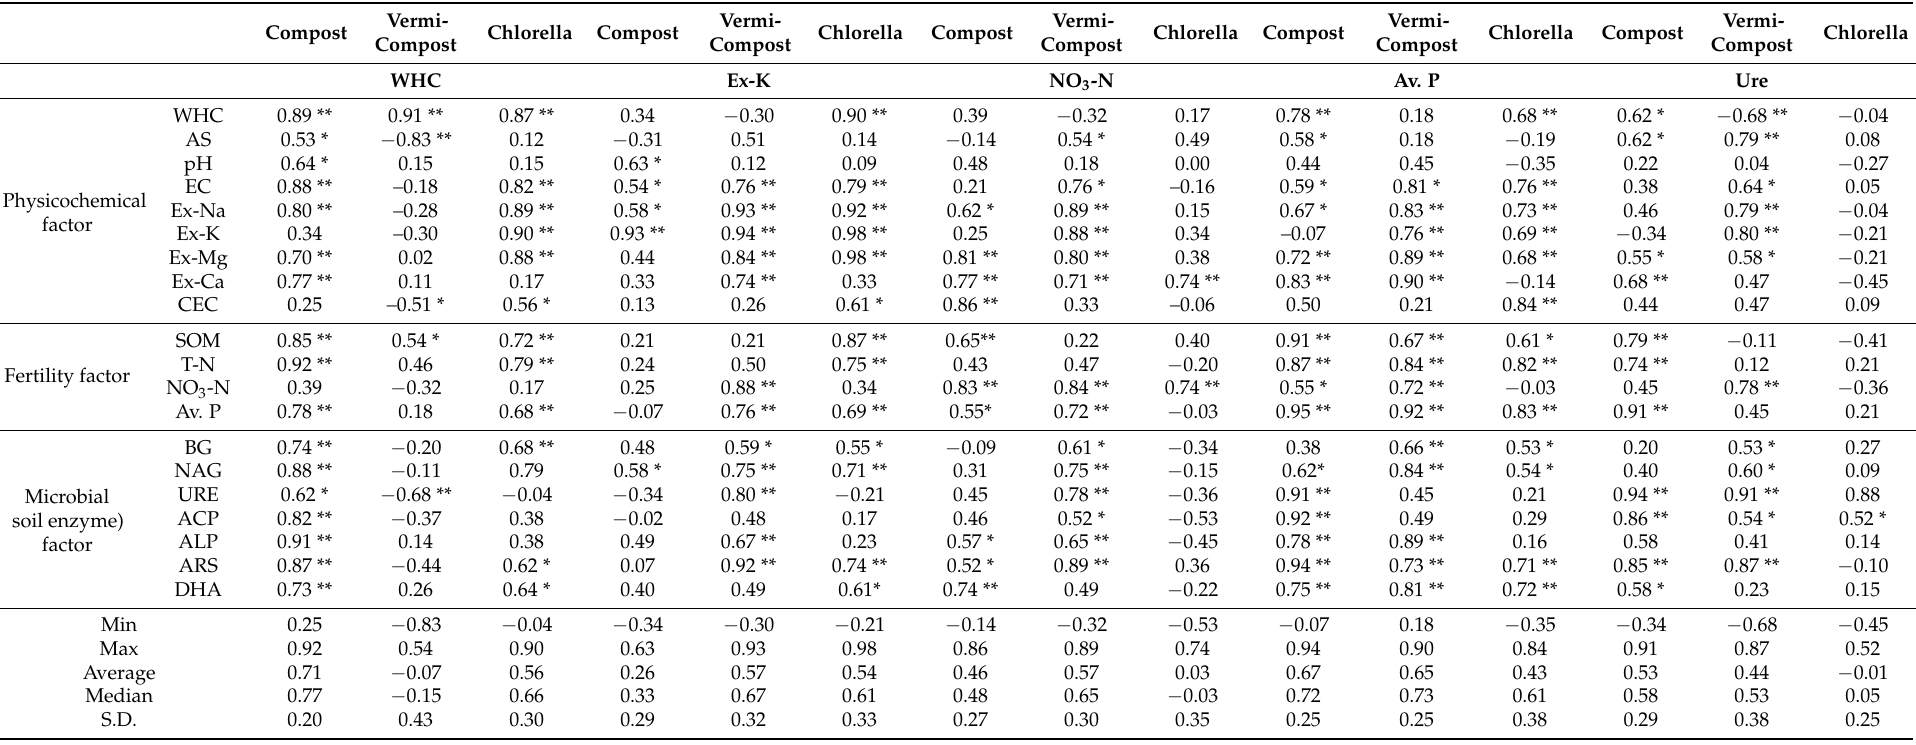
Table 4. Normalized correlation coefficients between deteriorated and other soil properties for three most effective amendments. ** Significance ( p -value) ≤ 0.01, * Significance ( p -value) ≤